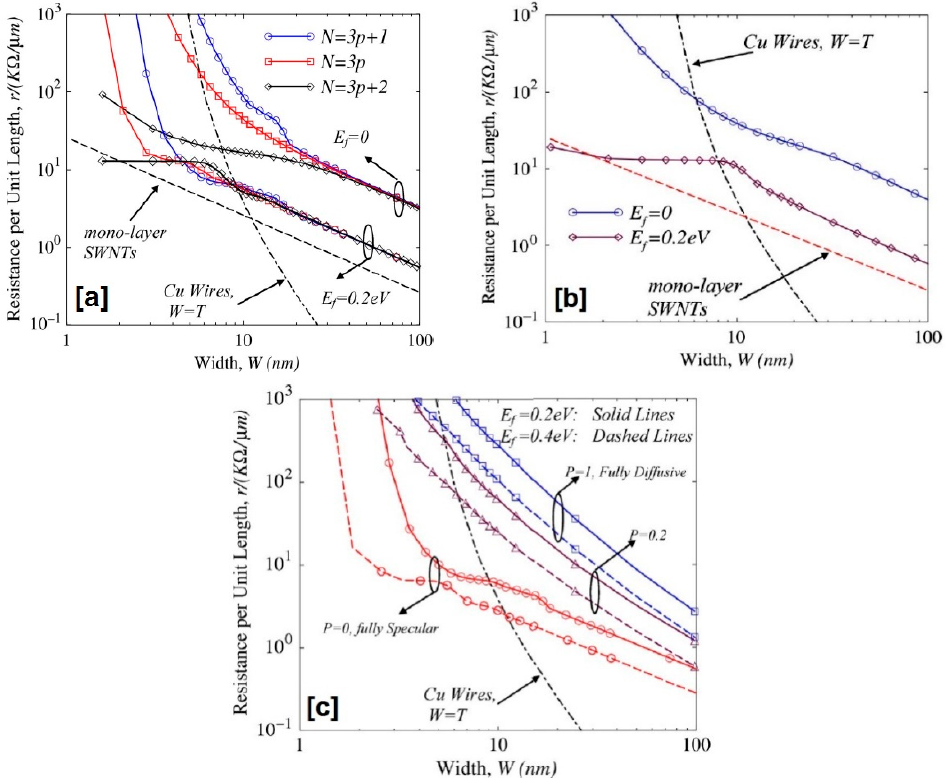
Figure 12. Resistance per unit length of GNRs plotted as a function of width comparing with Cu and SWCNT. ( a ) Armchair GNRs for smooth edge; ( b ) zigzag GNRs for smooth edge; ( c ) rough edge GNRs with backscattered probability P = 0, 0.2, and 1 [5]. Reproduced with permission from [5]. IEEE, 2009.